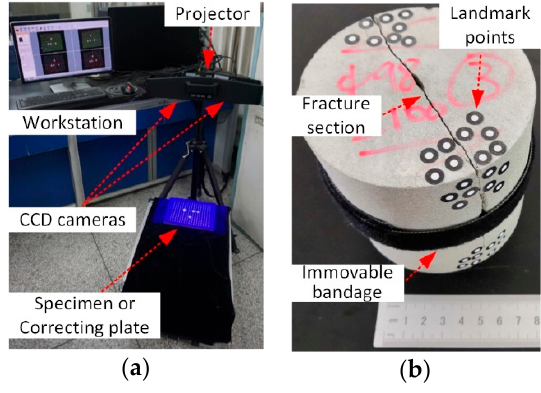
Figure 2. The ( a ) measurement system and ( b ) specimen.